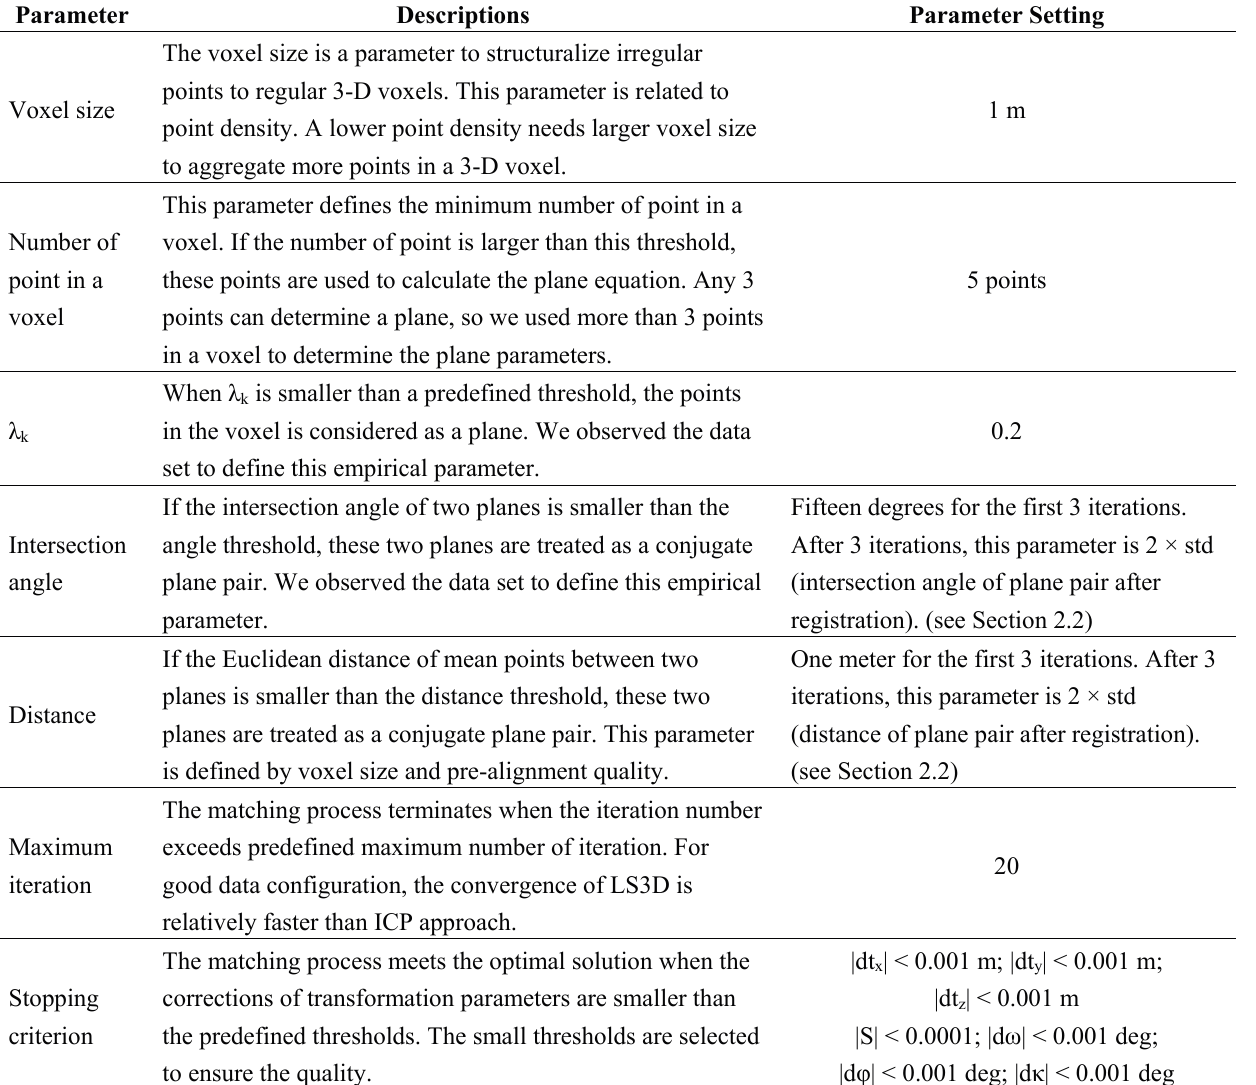
Table 1. The parameters setting and